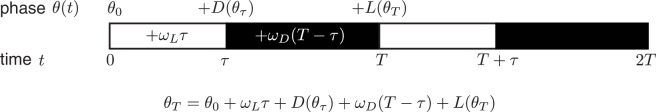
Phase oscillator entrainment.